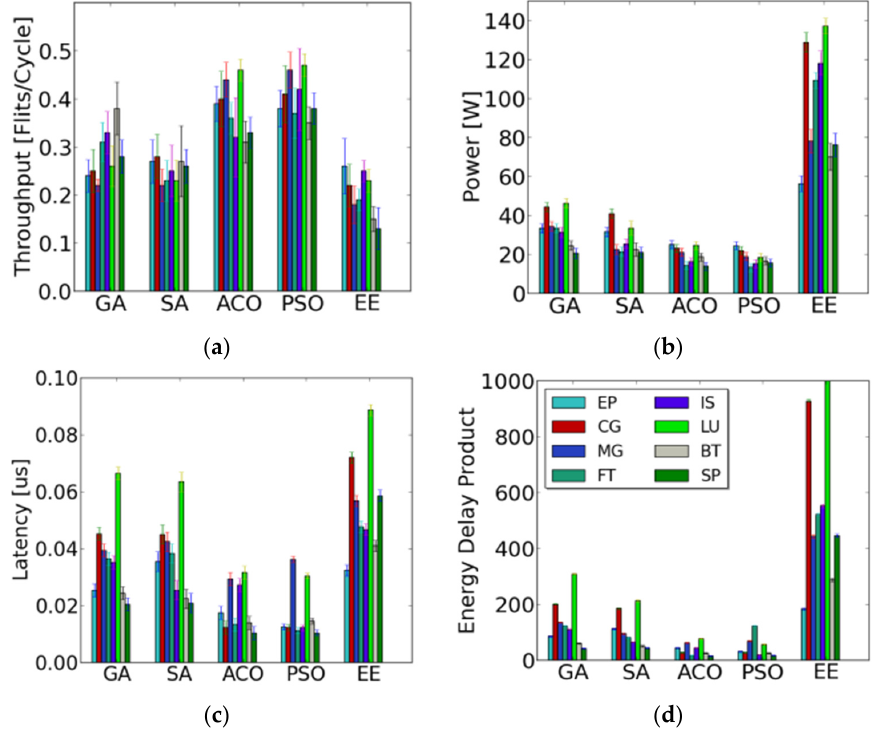
Figure 12. NAS [36] benchmarks comparison for 10 × 10 NoC. ( a ) throughput, ( b ) power, ( c ) latency, and ( d ) energy delay product. Electronics 2016 , 5 , 21